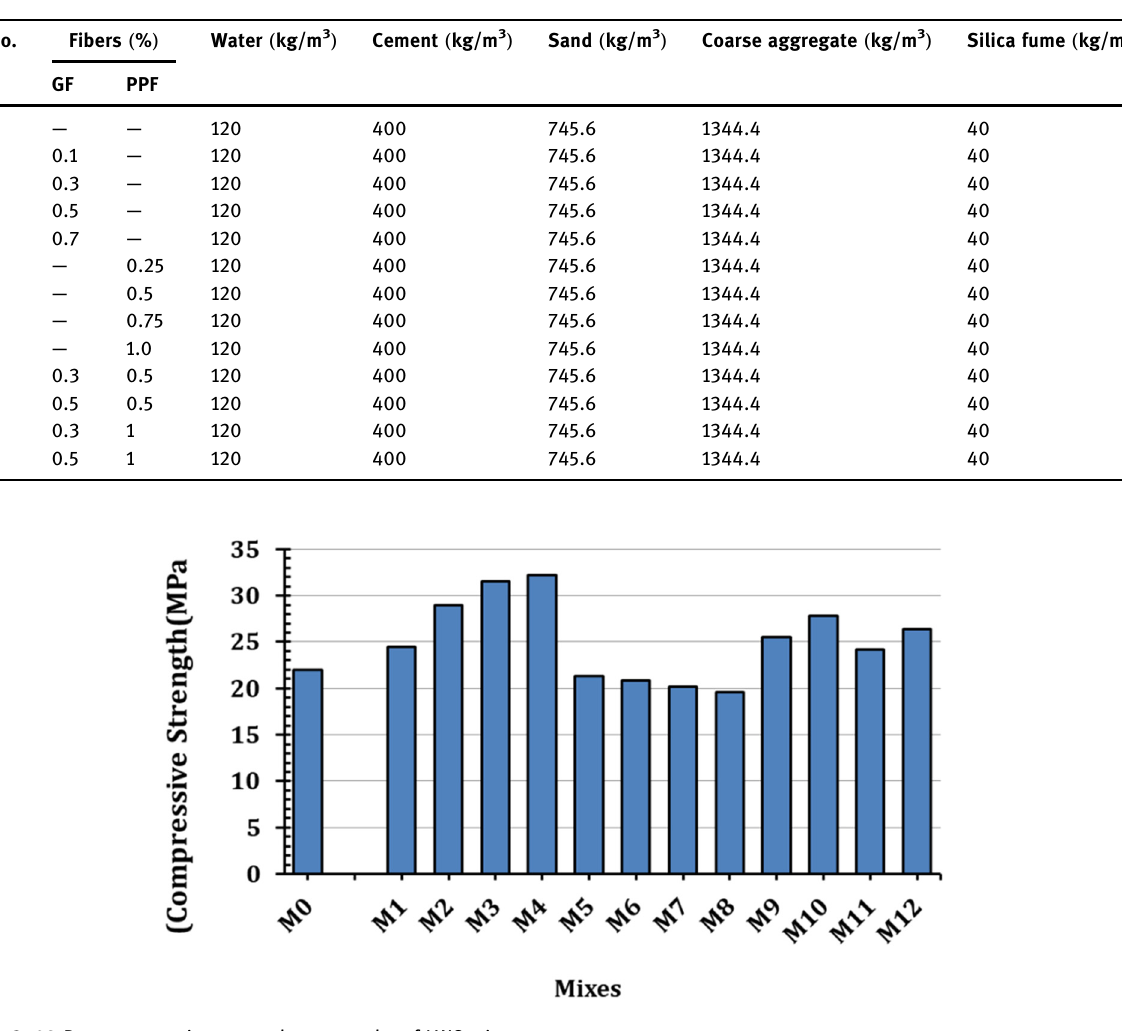
Figure 3: 28 - Day compressive strength test results of LWC mixes.